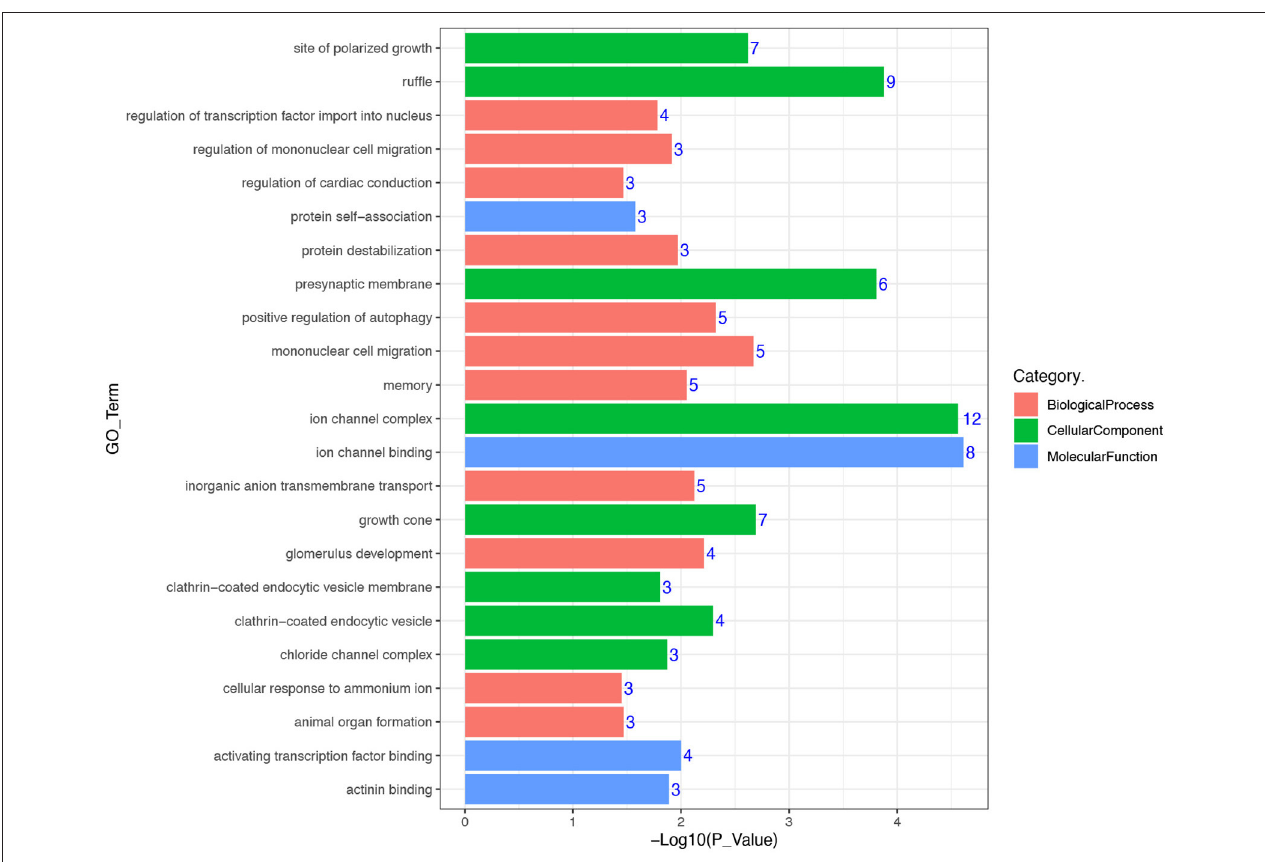
FIGURE 3 | Gene ontology (GO) enrichment analysis for the regional candidate genes with chromosome-wide significant